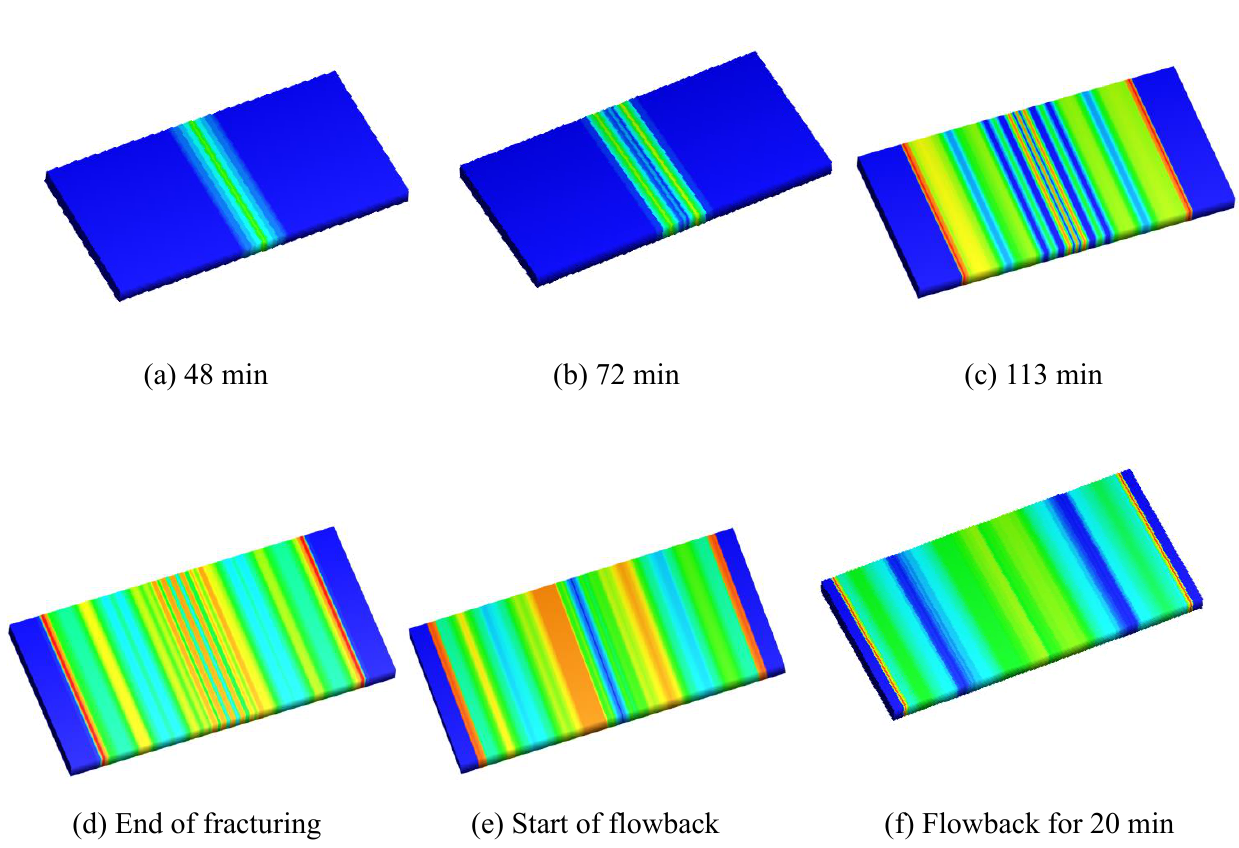
Figure 9—2D proppant distribution in the fracture in the course of injection and